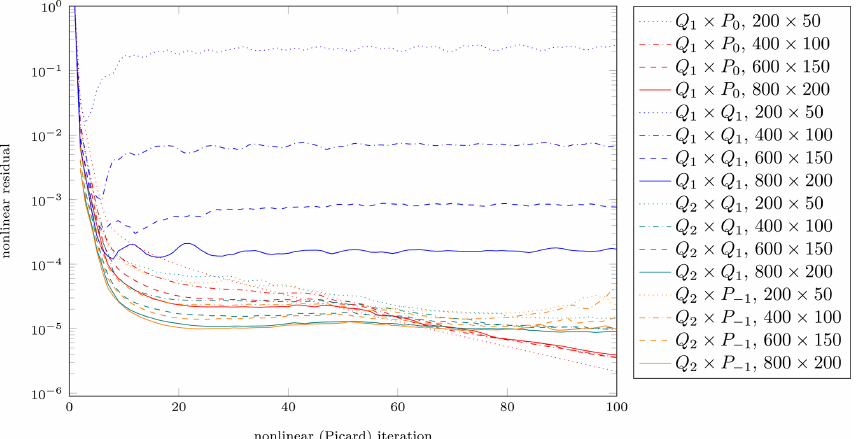
Figure 16. Application example. Nonlinear residual as a function of nonlinear iteration step for all four elements and for different mesh